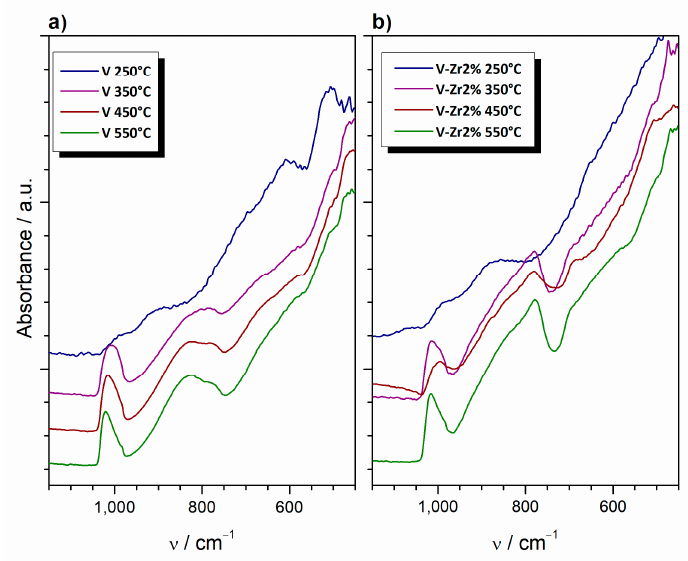
Figure 11. FTIR spectra of the samples ( a ) pure V and ( b ) V-Zr6%, whose thermal treatment was interrupted at temperatures of 250, 350, 450 and 550 °C.